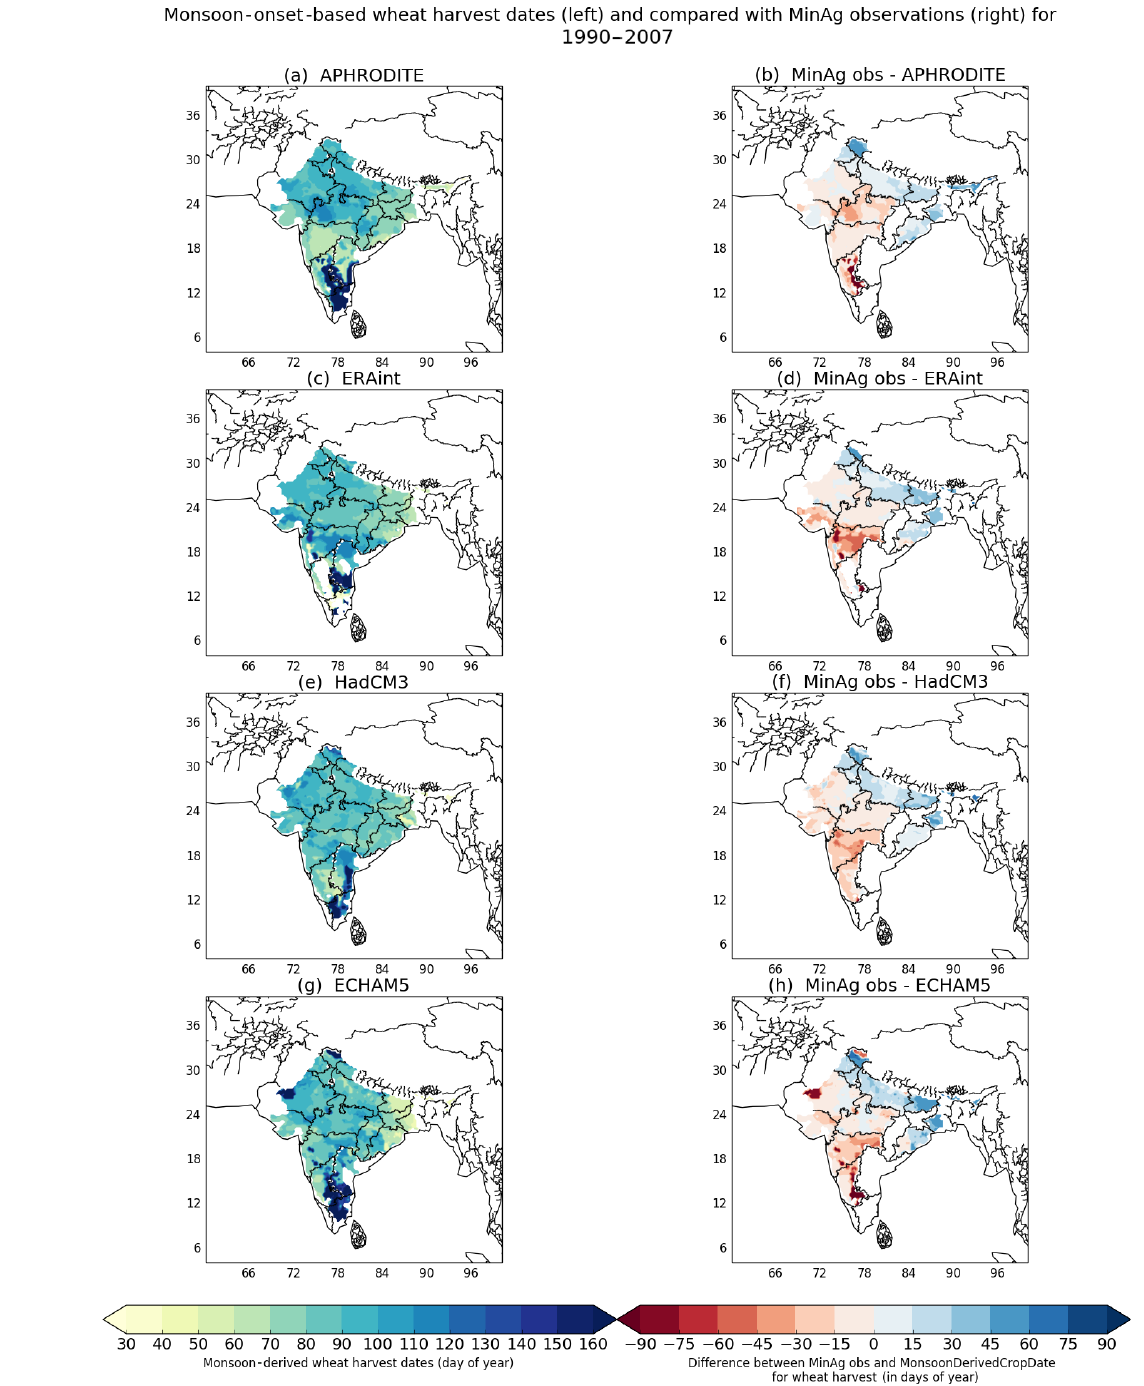
Figure C3. The monsoon-derived wheat harvest dates (a, c, e, g) and the difference between the MinAg observations and the monsoon- derived wheat harvest dates (b, d, f, h) for the period